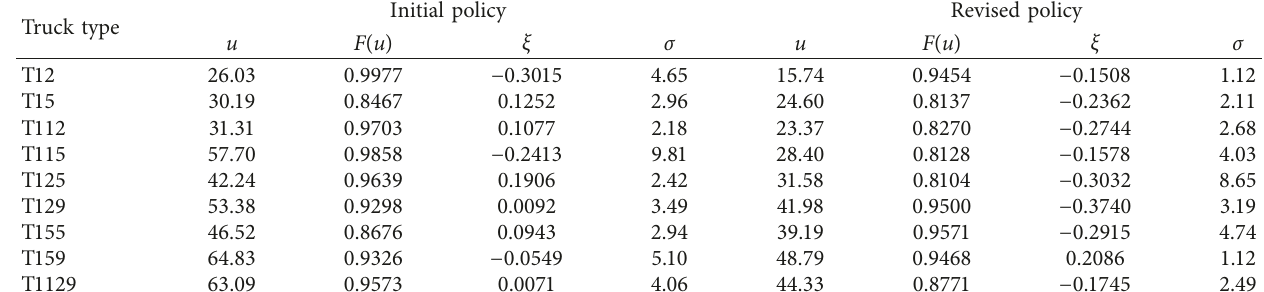
Table 9: Location ( u ), scale ( σ ), and shape ( ξ ) parameters of the GPD used to model GVW tail by truck type under the initial and revised toll- by-weight policies.